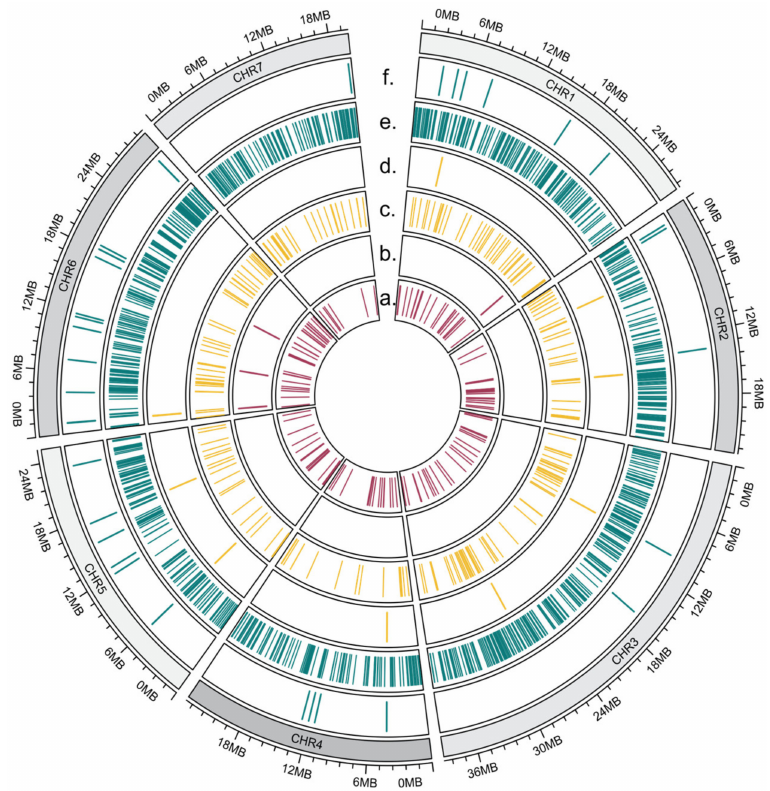
Figure 11. Circular map of chromosome distribution of differentially expressed miRNA genes ( b , d , f ) and their targets ( a , c , e ). Line S1 ( a , b ), line S2 ( c , d ), line S3 ( e , f